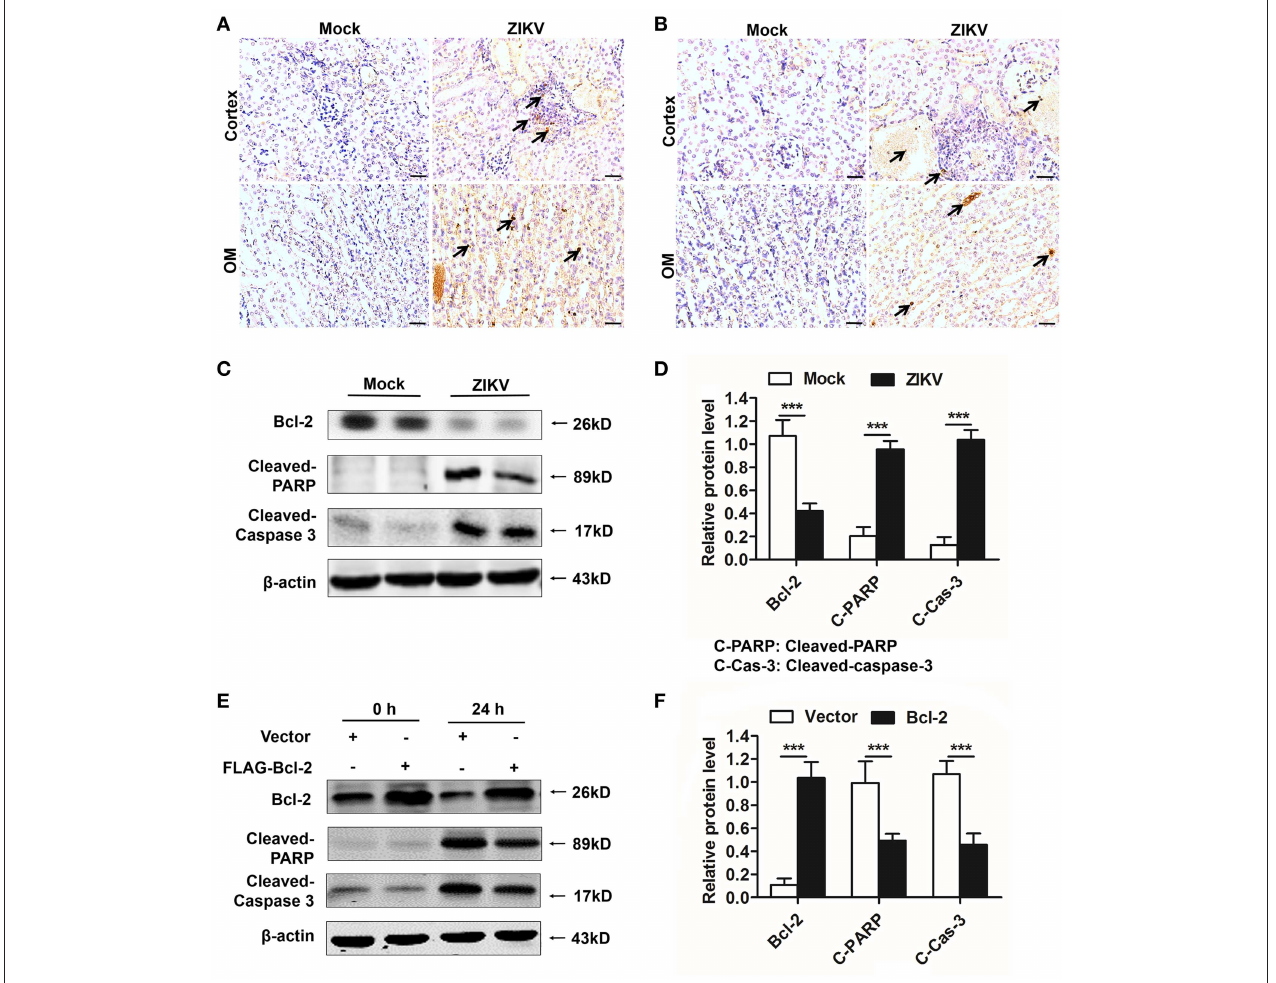
FIGURE 8 | Overexpression of Bcl-2 down-regulated the expression of cleaved caspase-3 and PARP in ZIKV-infected renal cells. (A,B) Cell apoptosis was tested in the kidneys of ZIKV- infected newborn (A) and adult mice (B) at 14 days post-infection using a TUNEL assay kit. Positive apoptotic cells detected by the DAB reagent had a brownish-yellow nucleus, which indicated by black arrows. Scale bars, 20 µ m. (C,D) The expression of Bcl-2, cleaved caspase-3, and cleaved PARP in the kidneys of newborn mice were assessed by western blot. (E,F) HK-2 cells were transfected with control vector or pSG5-FLAG-Bcl-2 plasmid (2 µ g/ml) for 24h followed by incubation with PBS (mock group) or ZIKV (MOI = 2) for 24h. Expression levels of FLAG, cleaved caspase-3 and cleaved PARP protein at 0h and 24h post-infection were assessed by western blot. Data were presented as mean ± SEM, (*** p < 0.001 vs. mock or vector